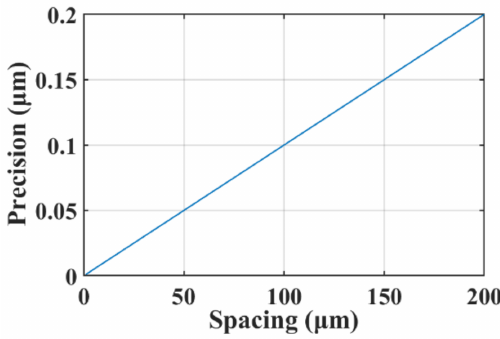
Figure 6. Calculation of the spacing measurement